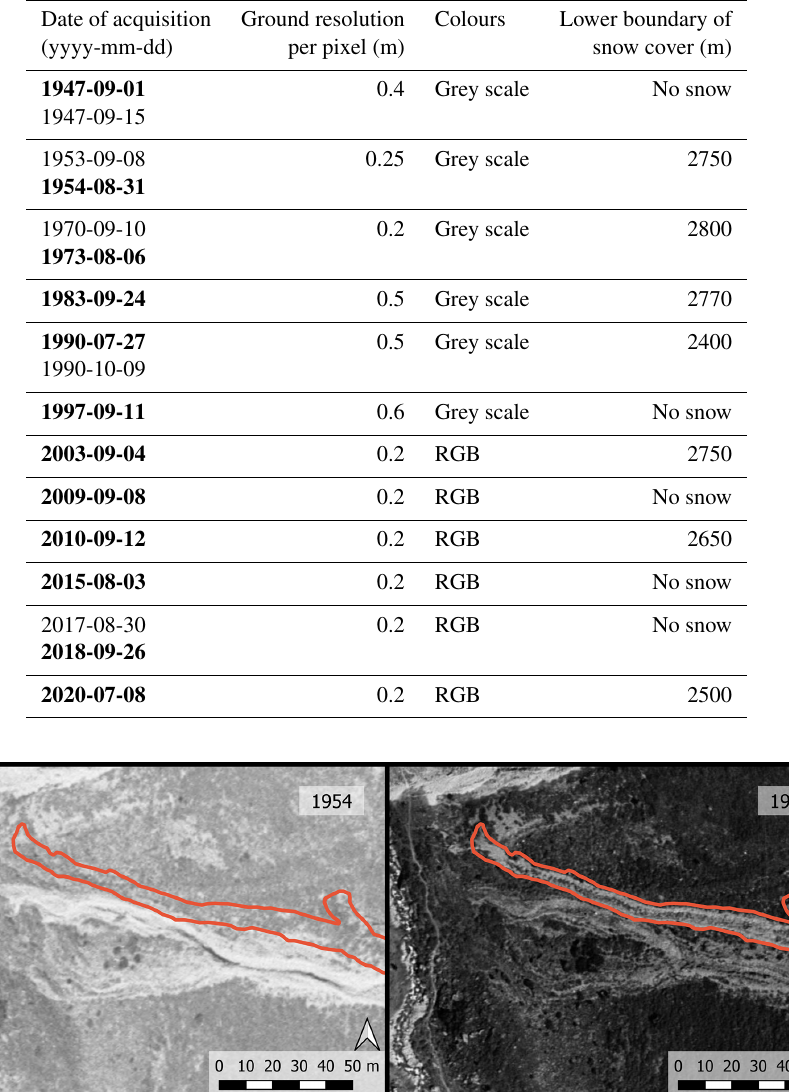
Figure 3. Example of the mapping process. The mapped debris flow (encircled in red) must have happened between the acquisition of the orthophotos 1954 (no debris flow landforms) and 1973. Sources of aerial images: Office of Metrology and Surveying and the Province of